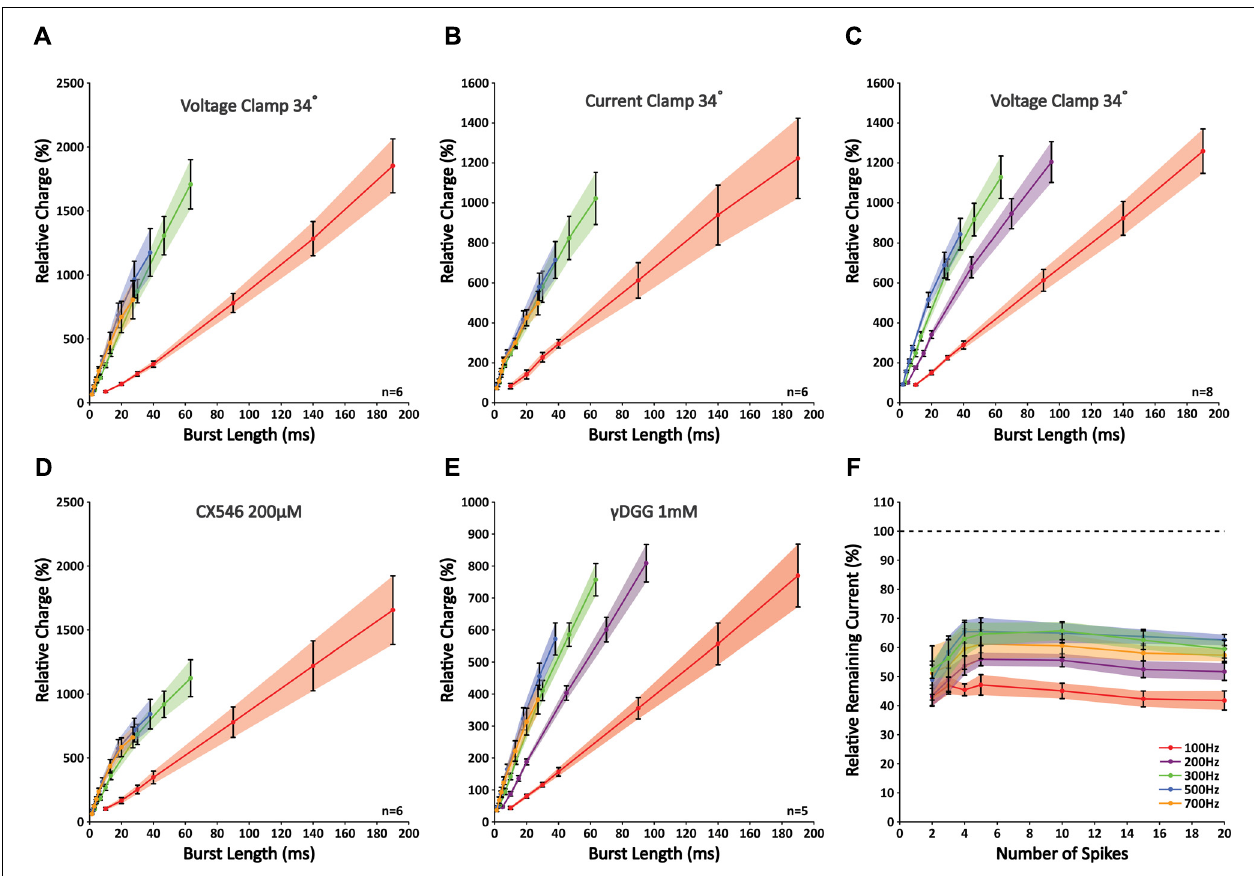
as a result of small facilitations for bursts smaller than 20 ms (see text). However, bursts that were shorter than 20 ms in duration still displayed a linear relationship and the slopes at 300, 500, and 700 Hz did not differ significantly from each other ( p > 0.05; n = 6). (E) Application of γ DGG (1 mM) did not affect the observed limitation of signaling at frequencies higher than 300 Hz ( n = 5). (F) γ DGG (1 mM) effectively suppressed all responses by more than 35%. Relative suppression was significantly smaller after five stimuli at 200, 300, and 500 Hz, although no further decrease was observed for longer stimulus trains.This indicates that release might be facilitated within the first few stimuli, but quickly reaches its optimum ( n =